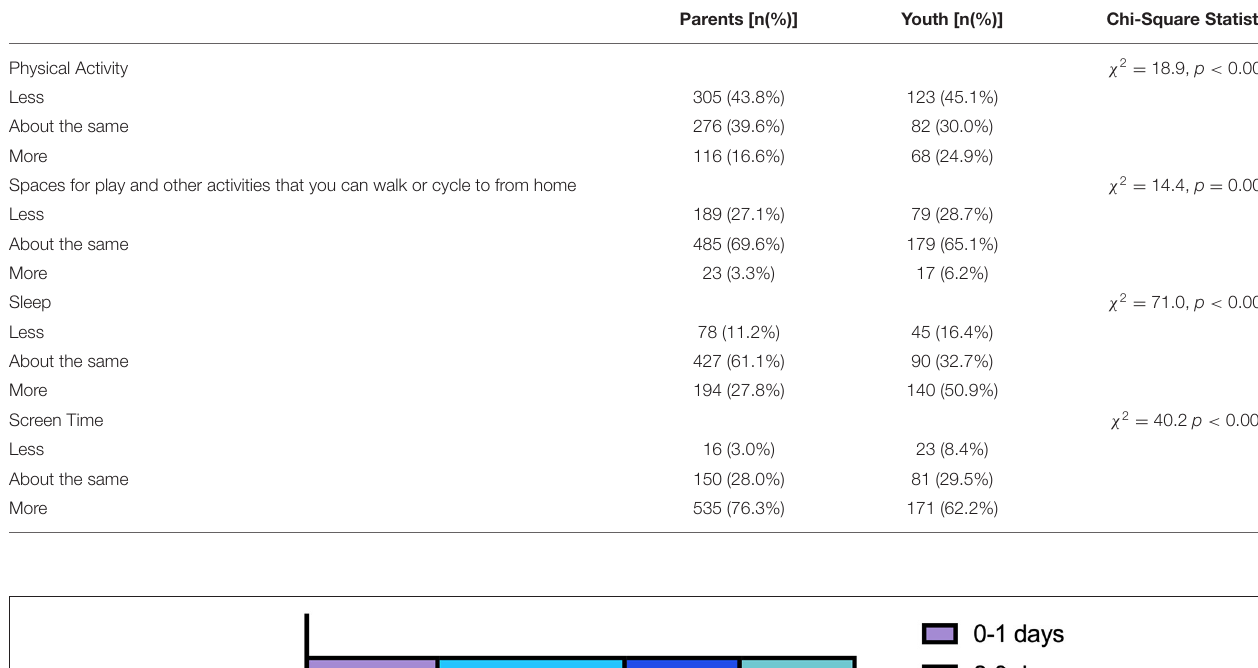
TABLE 3 | Changes in healthy behaviors compared to pre-pandemic.